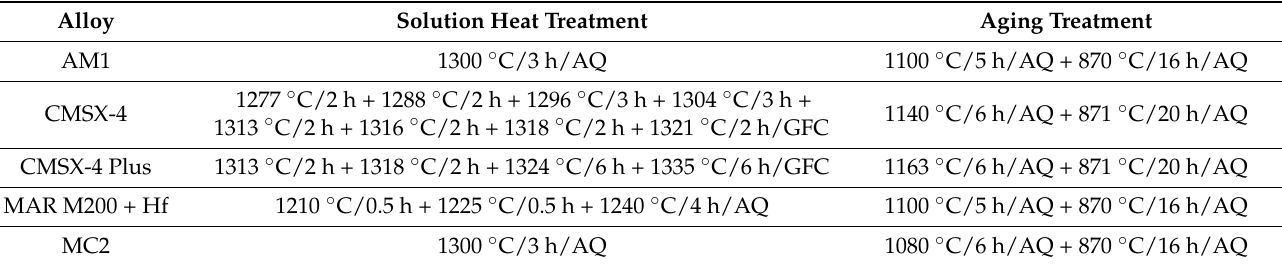
Figure 1. Example of the Ni-based single crystal superalloy microstructures (AM1 here) after ( a ) solution heat treatment, ( b ) aging treatments. Table 2. Applied solution and aging heat treatments.